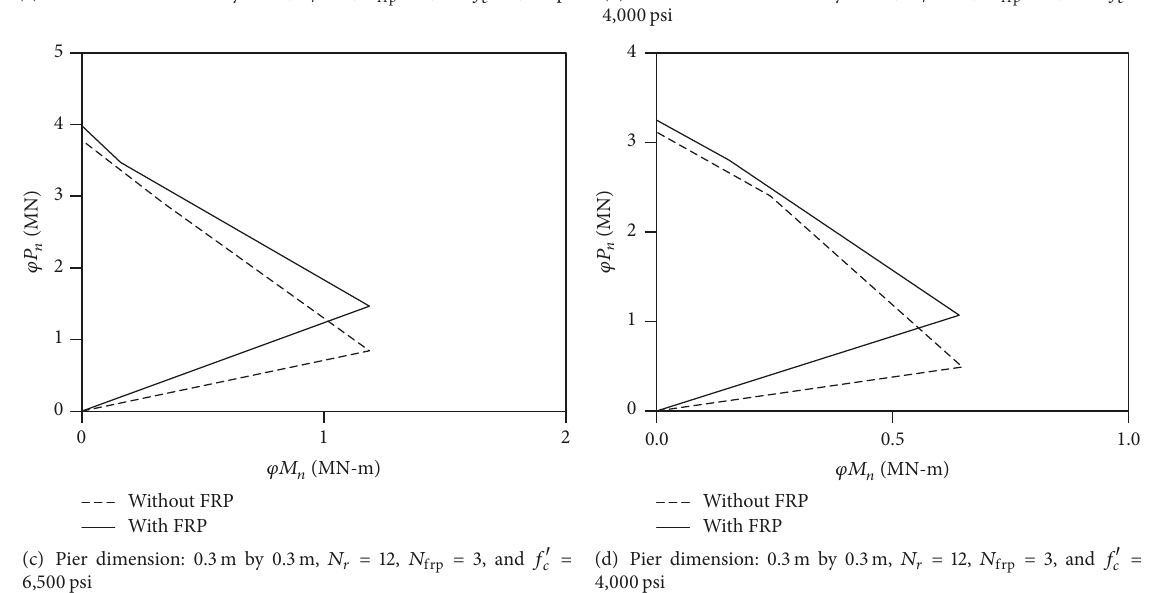
Figure 14: Simplified 𝑃 - 𝑀 interaction diagrams for rectangular reinforced concrete columns ( 𝑁 𝑟 = amount of rebar; 𝑁 frp = number of FRP plies; and 𝑓 󸀠 𝑐 = compressive strength of